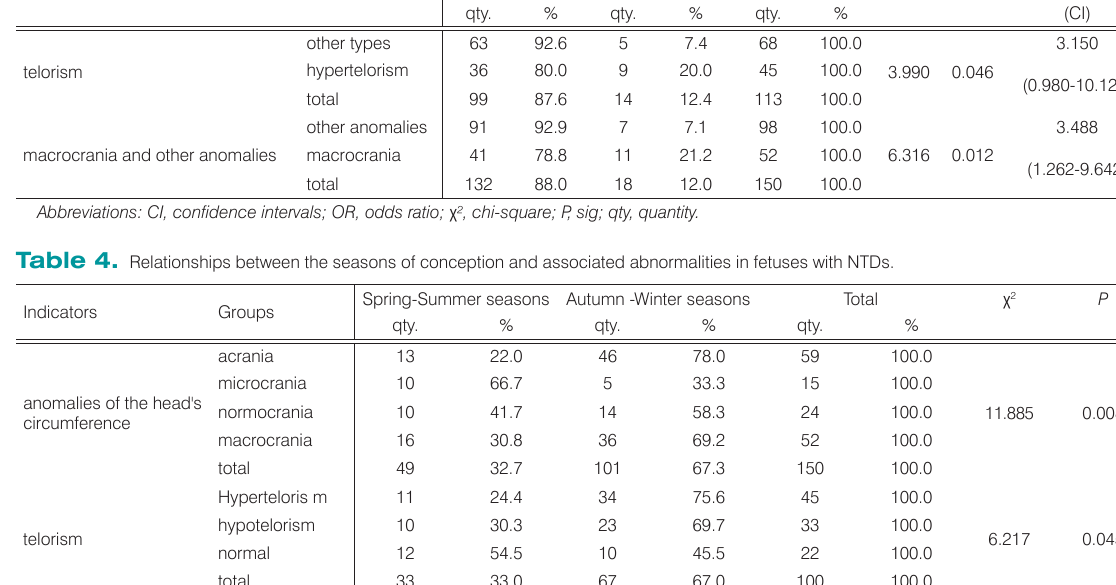
Figure 3 Amniotic fluid: Quantitative changes and associated anomalies in fetuses with NTDs.